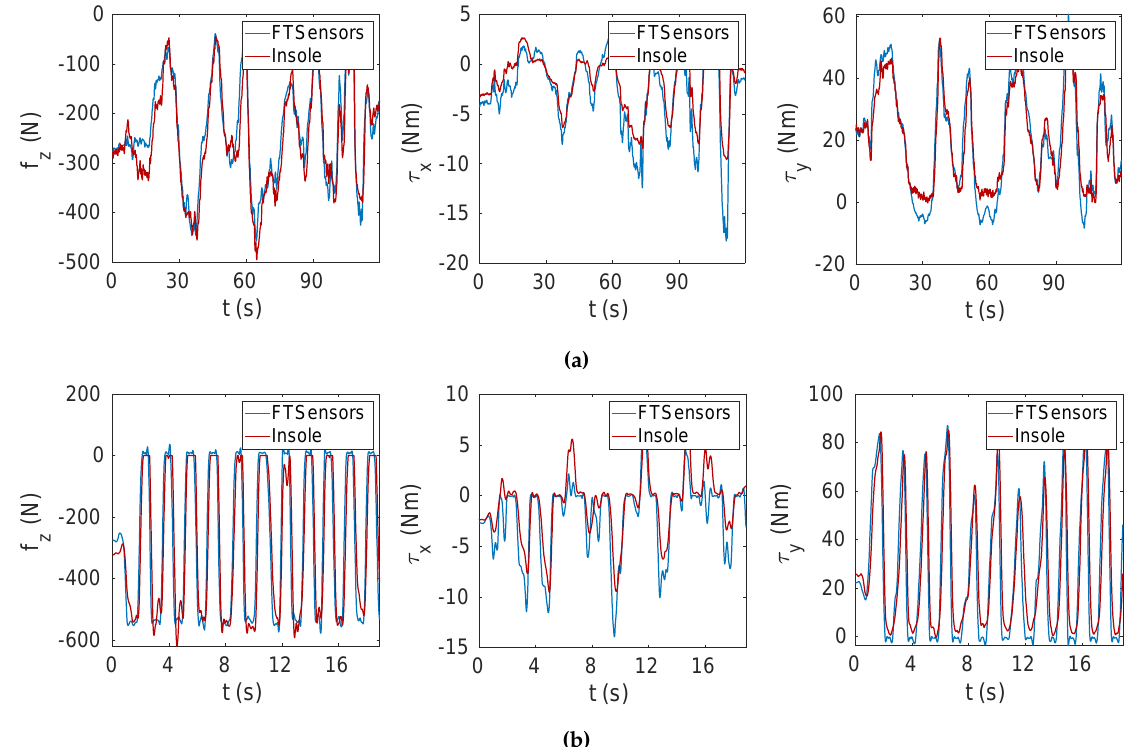
Figure 9. Vertical force f z and horizontal moments m x and m y tracking. ( a ) Task T3. ( b ) Task